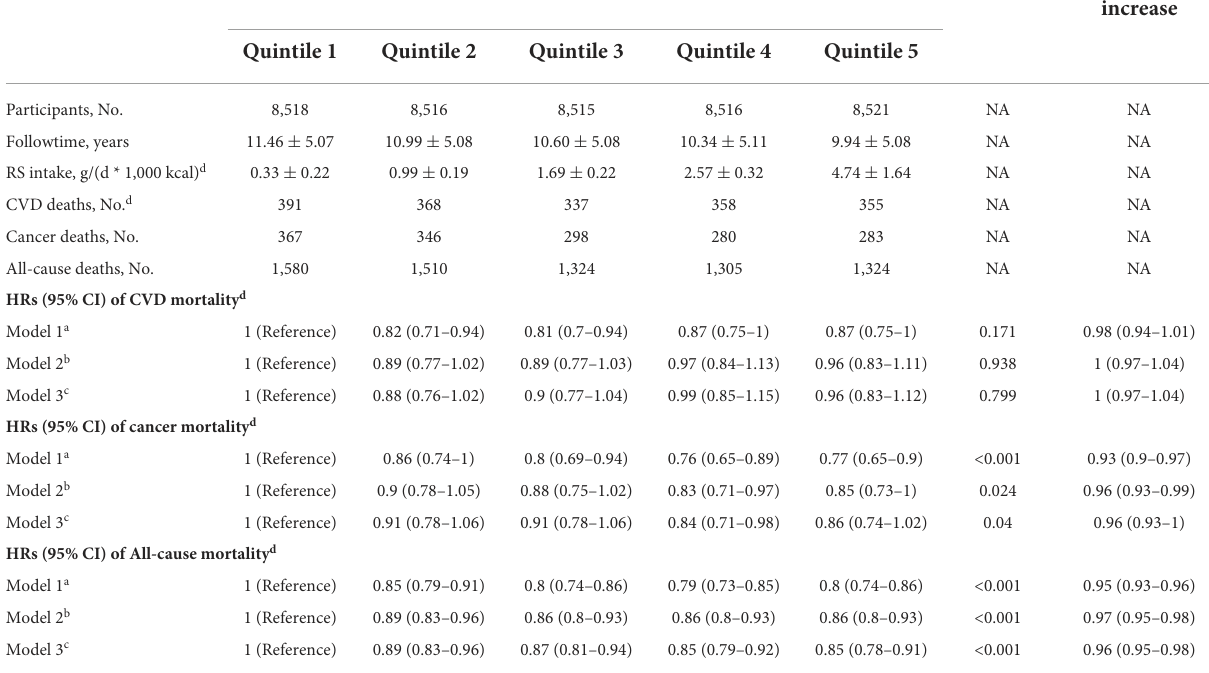
TABLE 2 Associations between resistant starch intake and